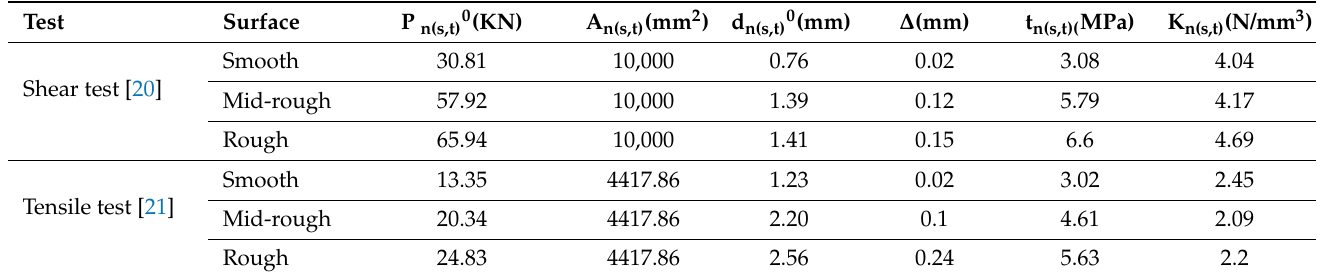
Table 1. Calculation of surface-based cohesive model parameters for various surfaces.